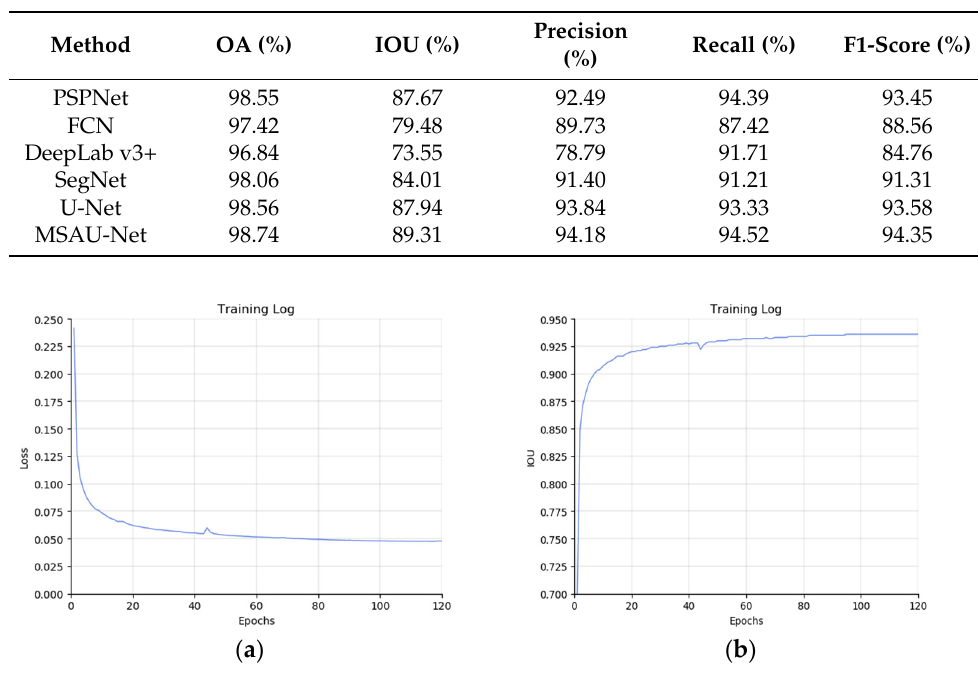
Figure 6. Plots showing the loss and IOU of the proposed model for training the WHU building dataset. The training loss ( a ) and the IOU ( b ) change when the epochs increase.